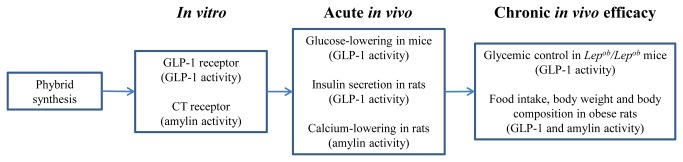
Flowchart of phybrid characterization of receptor activity and in
vivo efficacy.After synthesis, the ability of the GLP-1 and amylinomimetic portions of the phybrid to activate their appropriate receptors was assessed: activation of cAMP in cells expressing the GLP-1R or the CT receptor. Acute in
vivo characteristics of GLP-1 and amylin physiology were then assessed: glucose-lowering in mice for GLP-1 activity, insulin secretion in rats for GLP-1 activity and calcium-lowering in rats for amylin activity. In chronic efficacy models to more accurately gauge the ability of the phybrids to render equal or superior metabolic control relative to mono- or dual-therapy we utilized two models: obese, diabetic mice to assess impact on chronic glucose control, and DIO rats to assess impact on food intake, body weight and body composition.